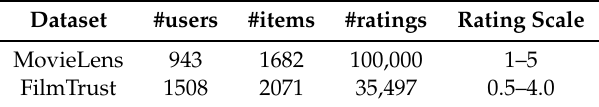
Table 2. Main properties of the datasets used in